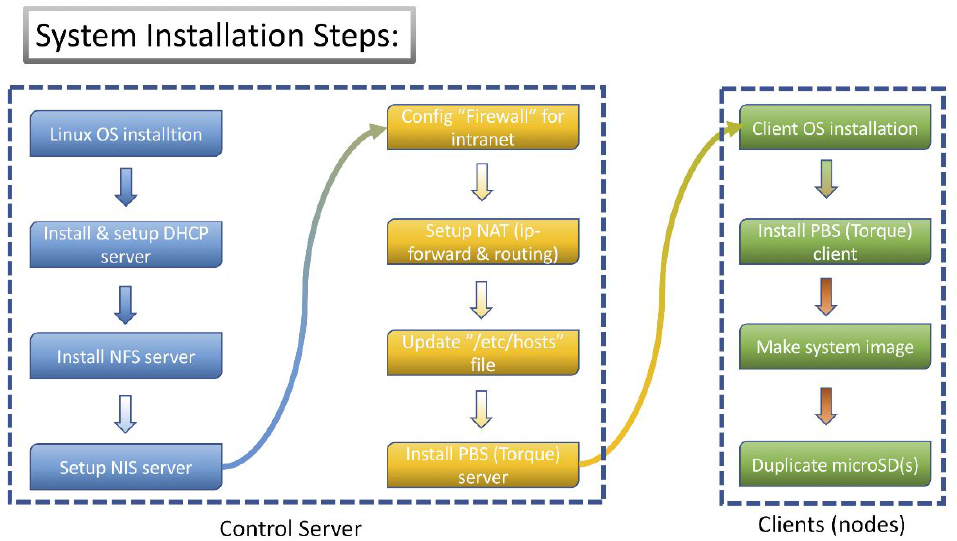
Figure 3. The installation process of the operating system. Blue and yellow boxes indicate server operations; green boxes are node operations.